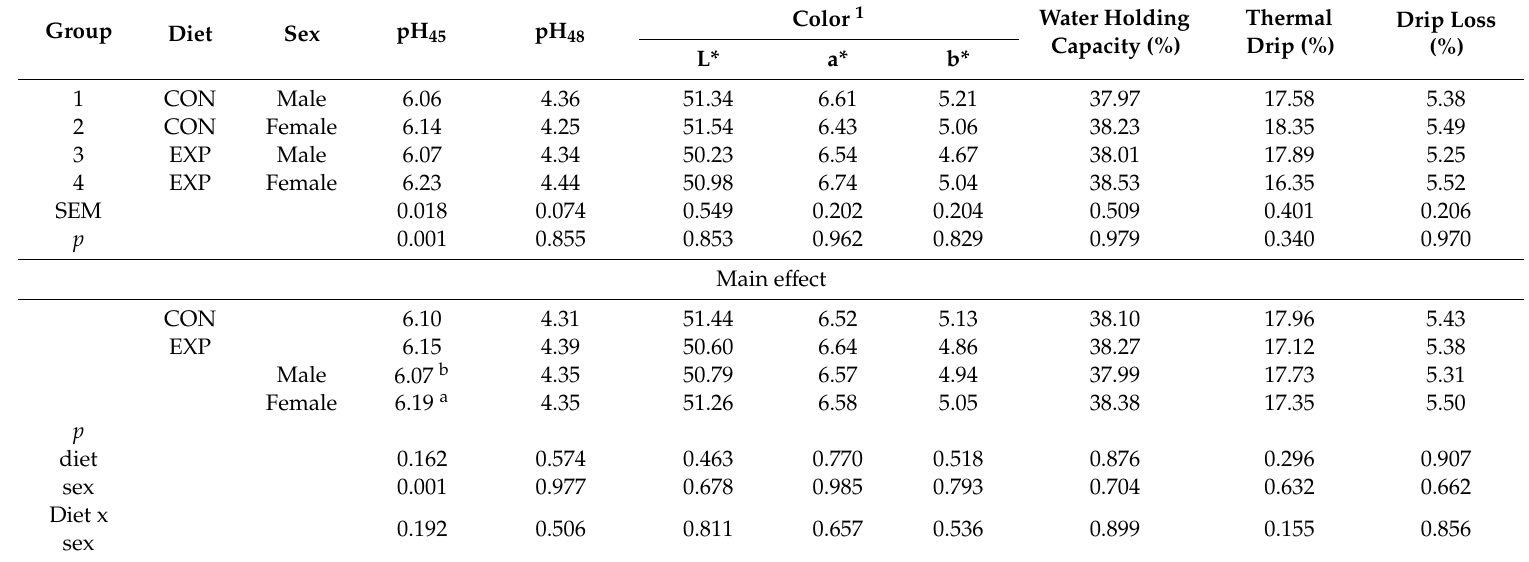
Table 5. Physicochemical parameters of pork meat